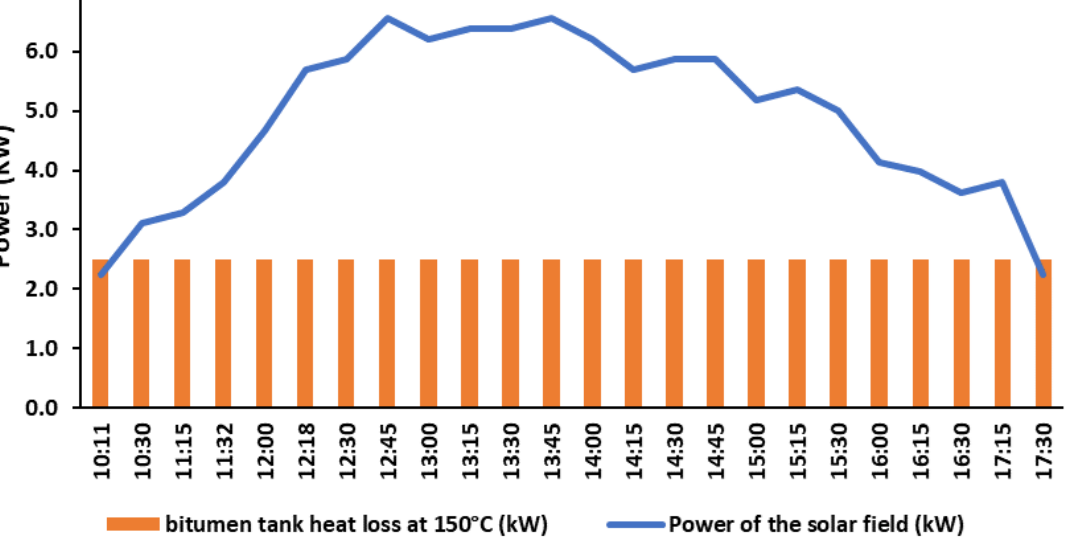
Figure 12. Evolution of the power supplied by the PTC solar field vs. the bitumen tank heat loss.